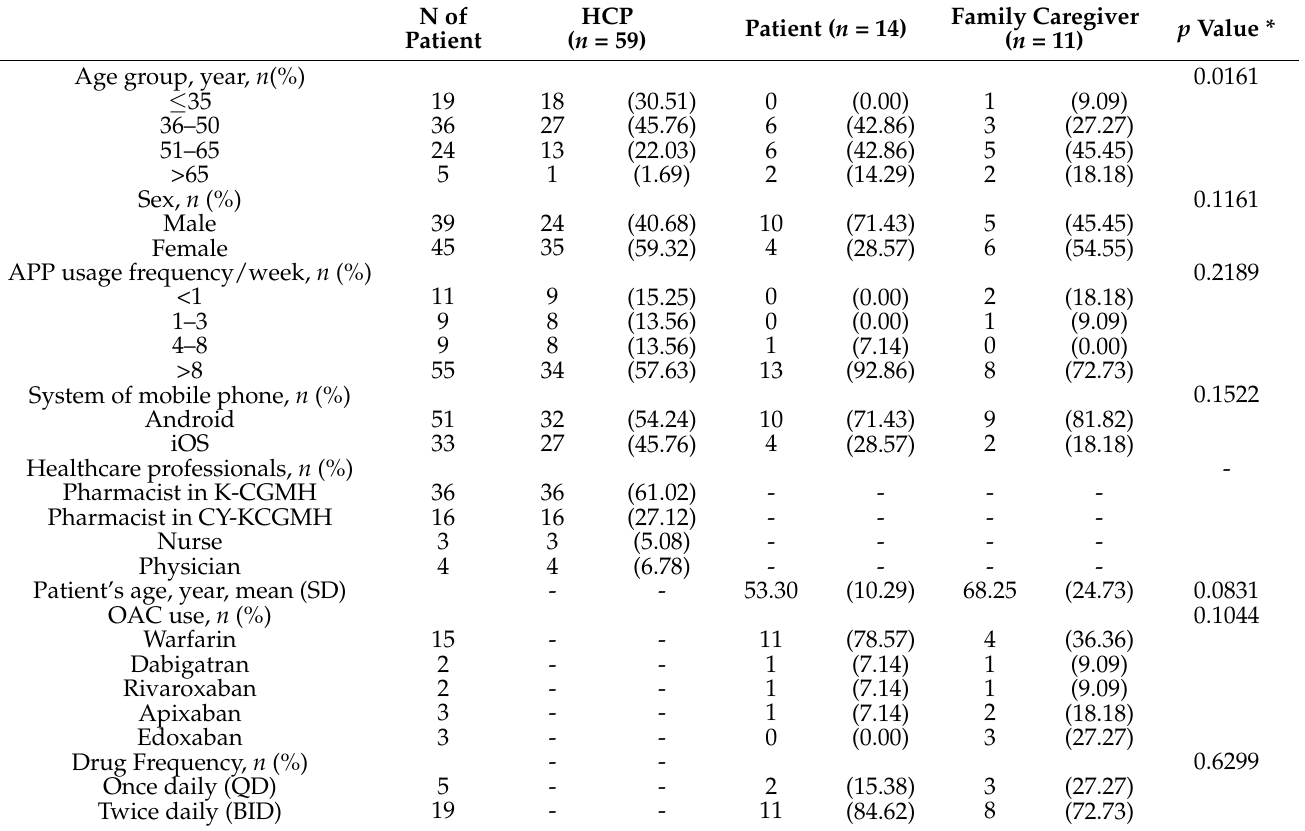
Table 1. Characteristics of study